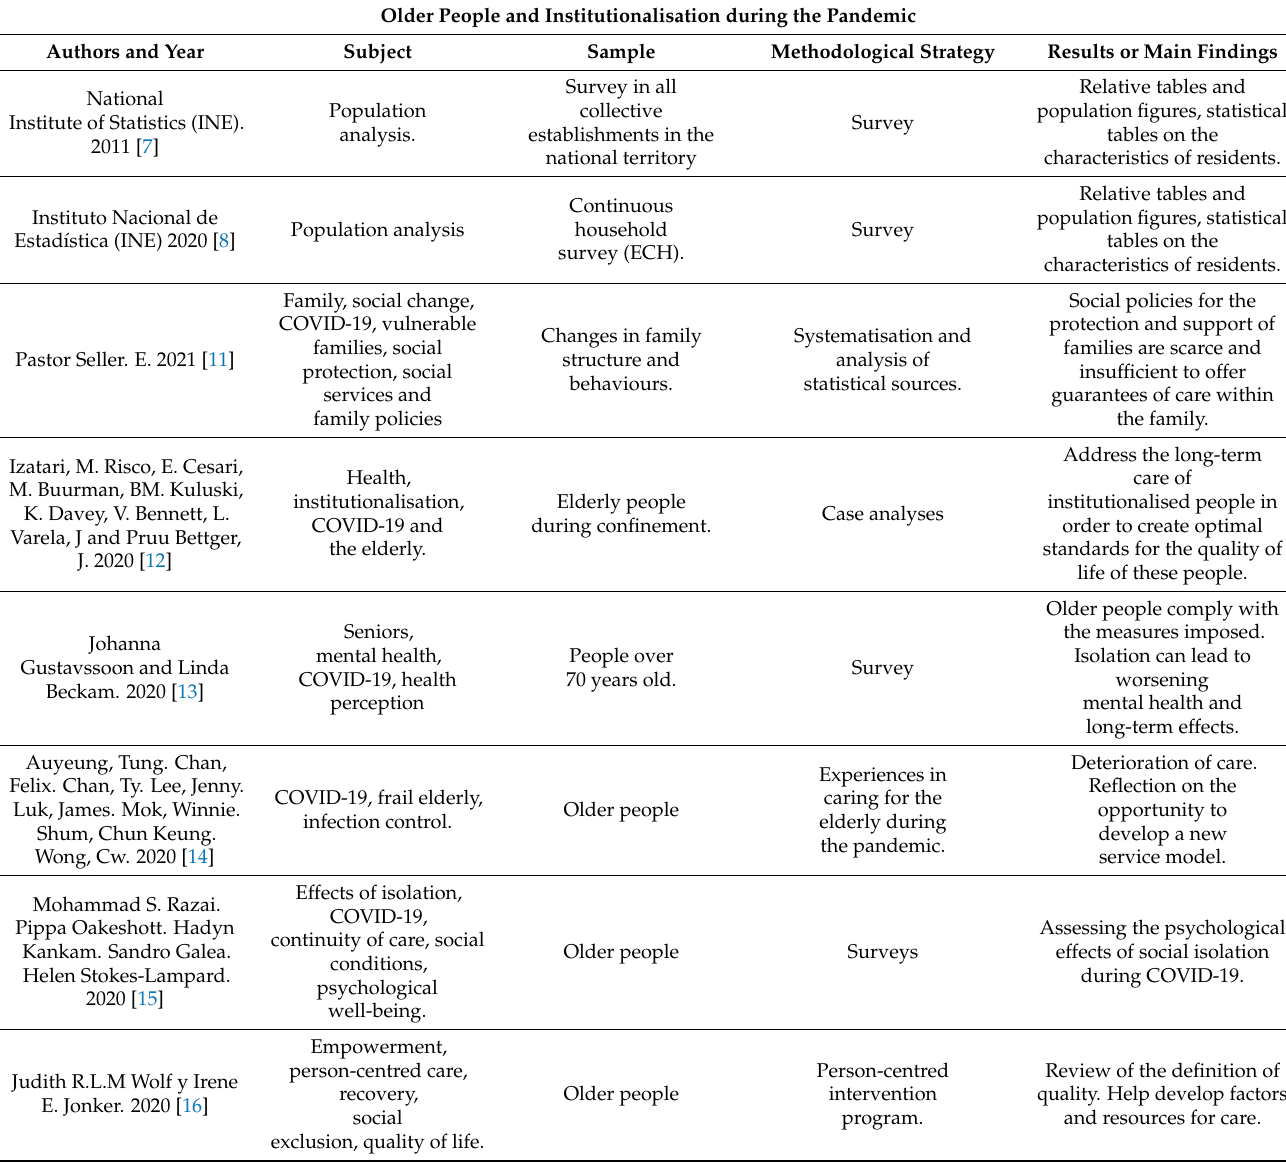
Table 3. Articles selected according to area and topic of interest. Source: own